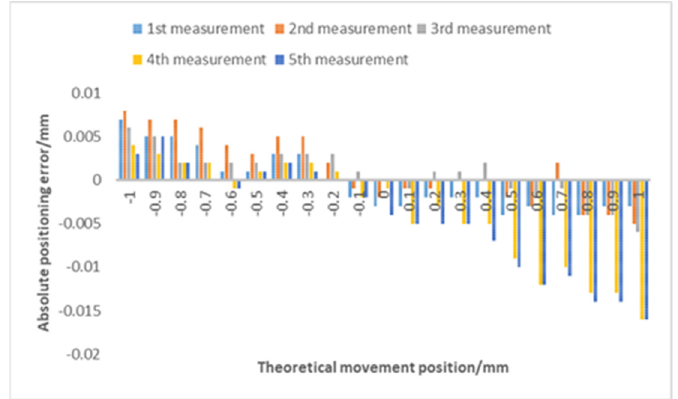
Figure 14. Absolute positioning error in the z-direction at each position point.